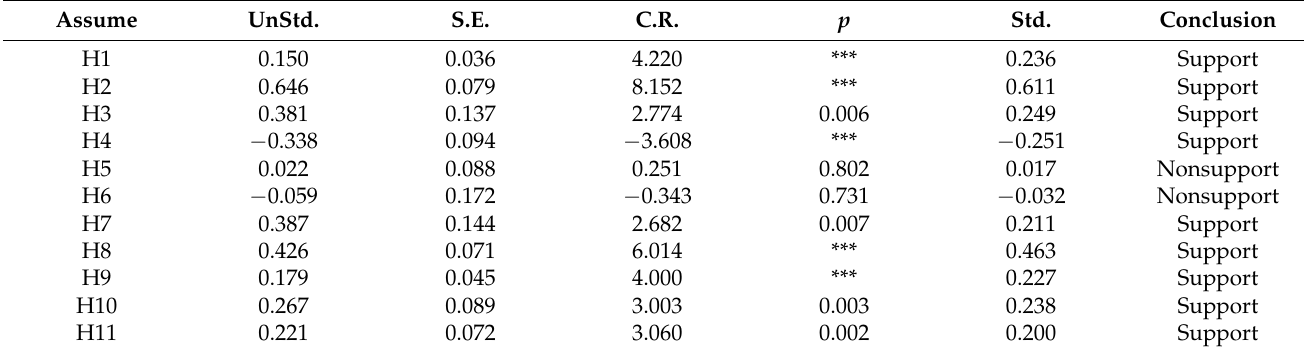
Table 10. Results of the hypothesis